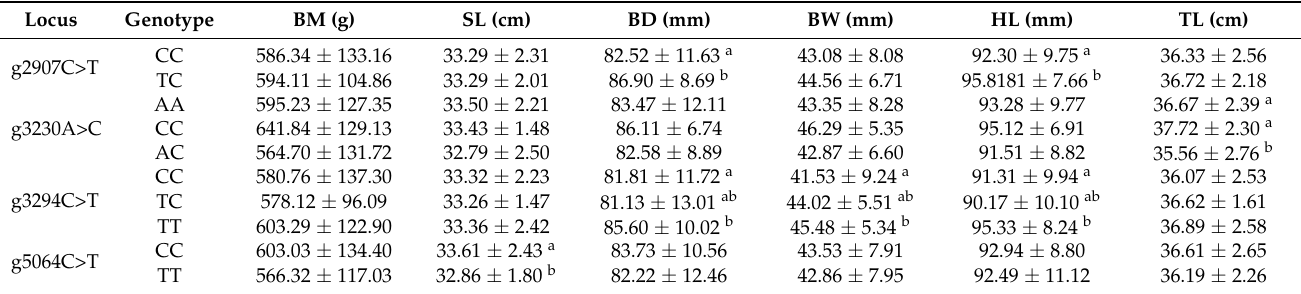
Table 4. Association of genotypes of igf2 SNPs with growth trait in L.